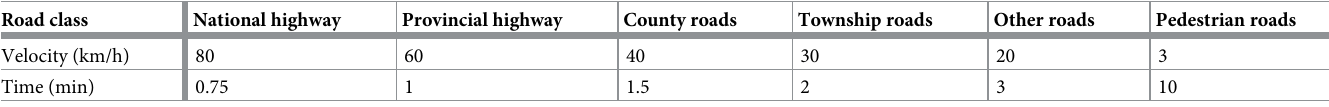
Table 1. Composition and speed of the road network in Lushunkou